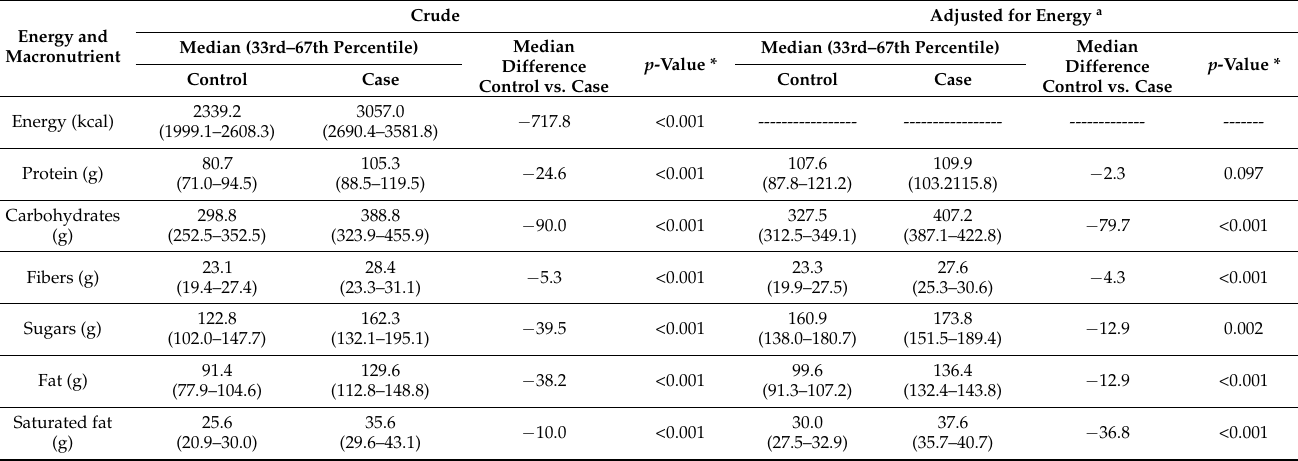
Table 2. Median daily intake and 33rd and 67th percentile of energy and macronutrients for 173 gastric cancer cases and 314 controls participating in a case-control study between